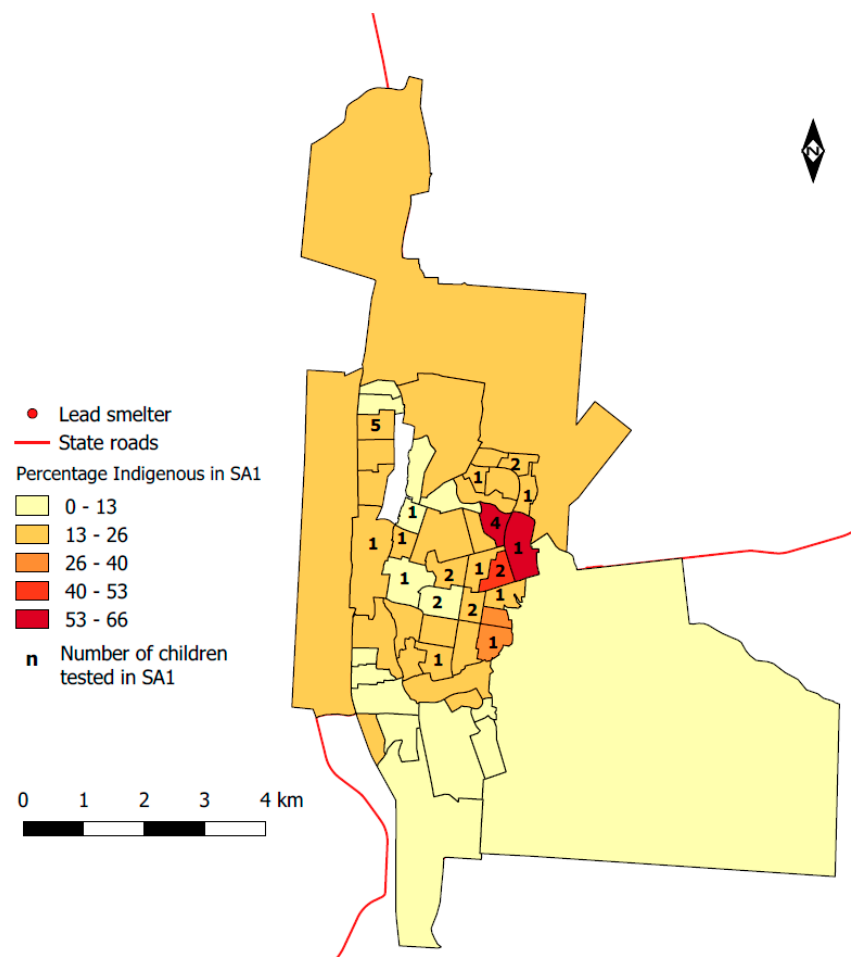
Figure 1. Map of Mount Isa with percentage of residents of Indigenous status and the number of children tested for blood lead levels in this study by Statistical Area 1 (SA1).